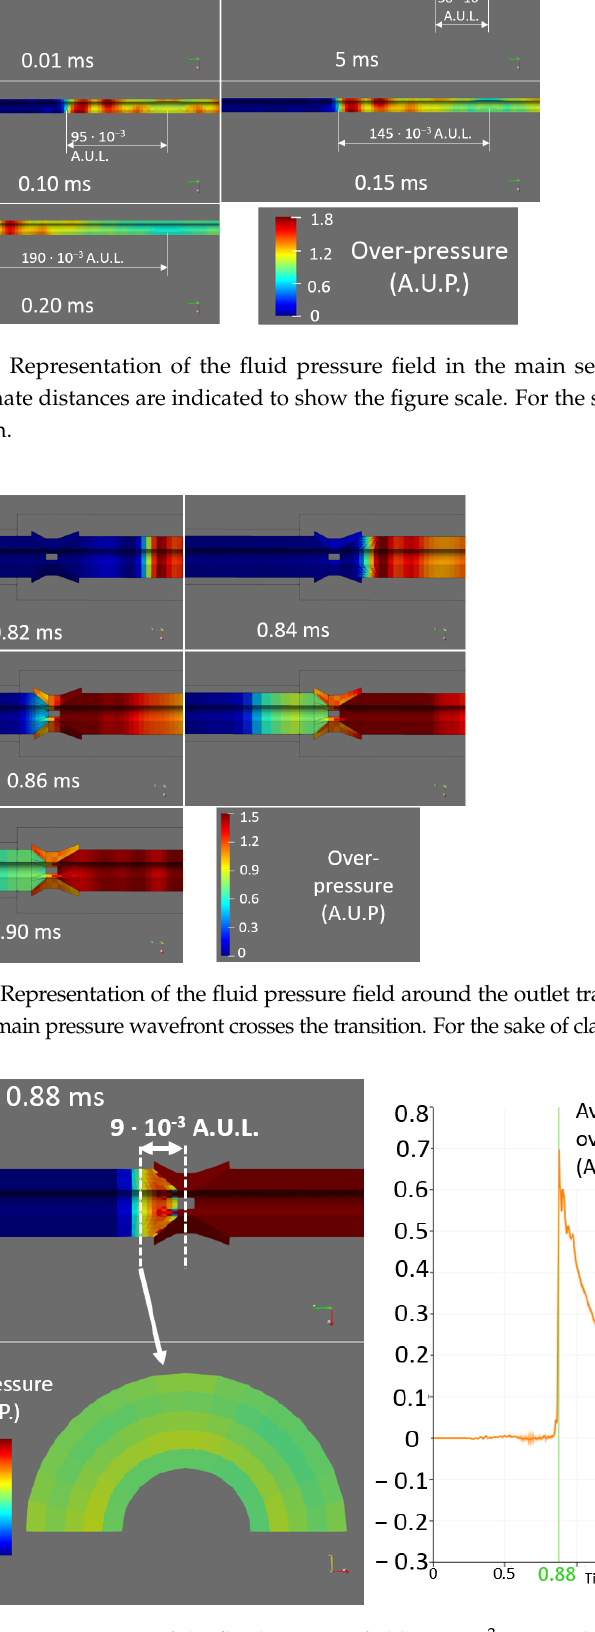
Figure 7. Representation of the fluid pressure field 9 × 10 − 3 A.U.L. downstream from the center of the outlet transition, when the main wavefront reaches the section (at 0.88